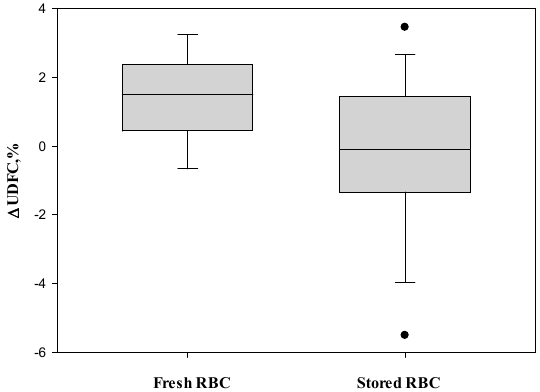
Figure 3. Alteration (after rolling cells with steel beads) of the percentage of undeformable cells ( Δ UDFC, %) in the RBC population for fresh and stored samples. No significant difference between the two groups, p = 0.154.